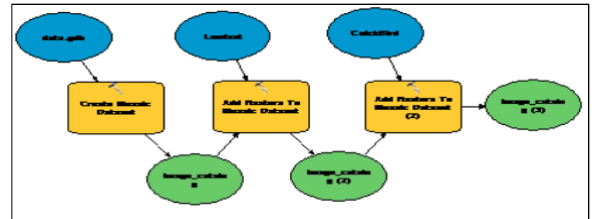
Figure 9. Geoprocessing model creating a mosaic dataset for cataloging and searching